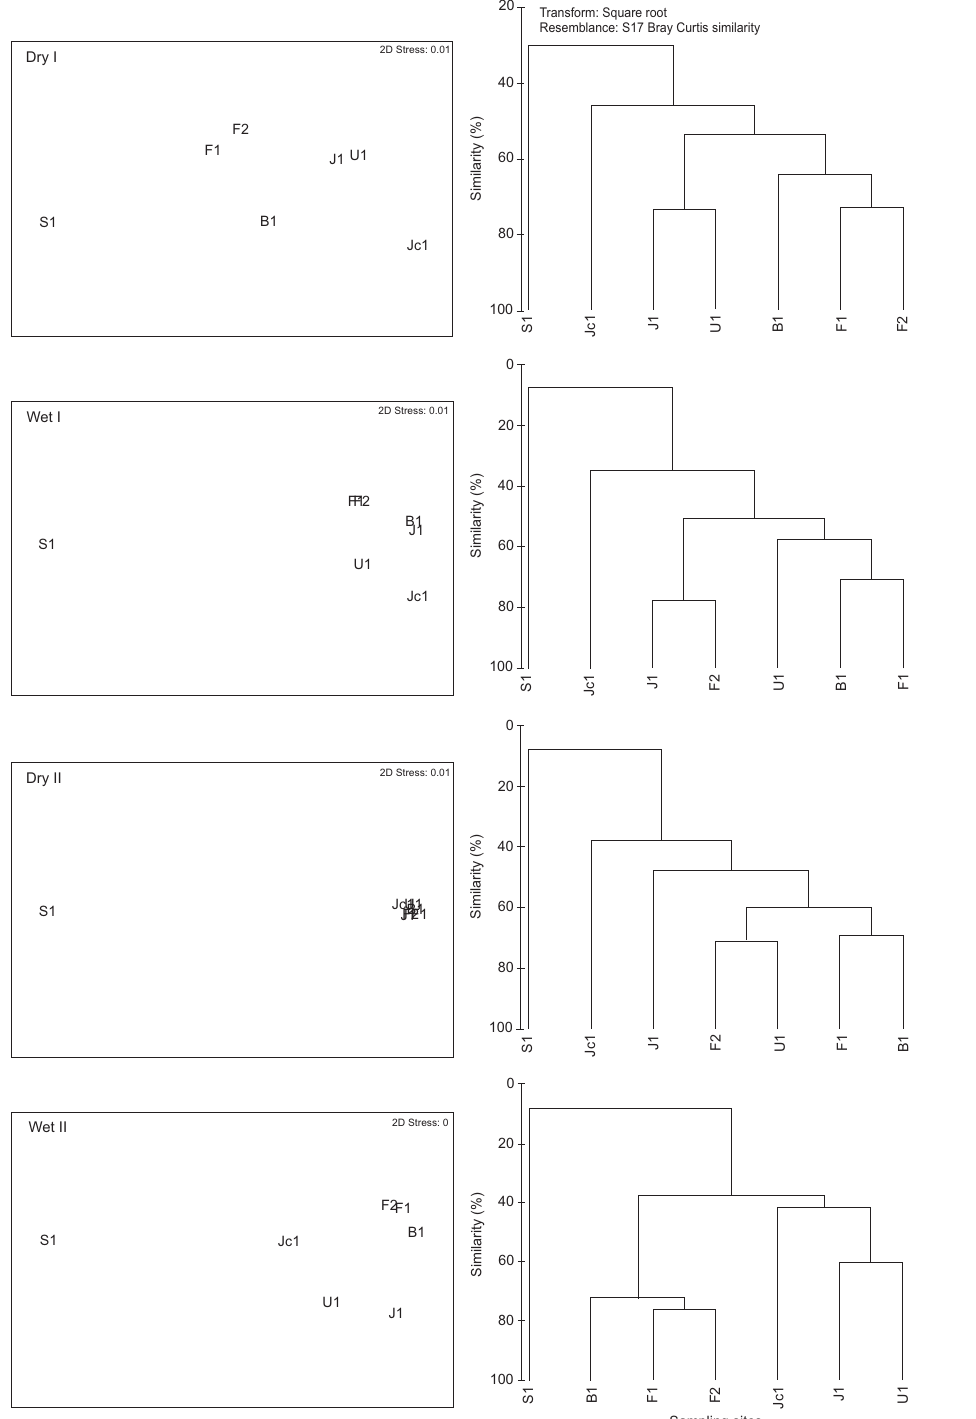
Figure 5. MDS ordinations and cluster dendrograms of macrofaunal assemblages per sampling period, using the Bray-Curtis similarity of square root transformed abundance